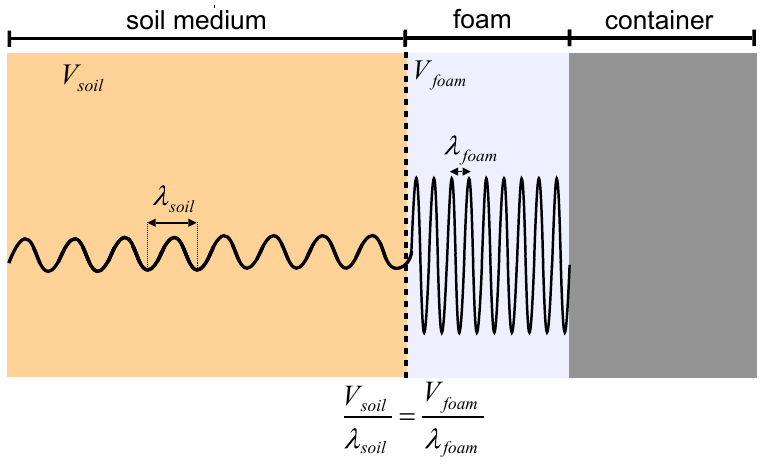
Figure 28. Schematic of wave propagation within a soil container having absorbing boundaries.